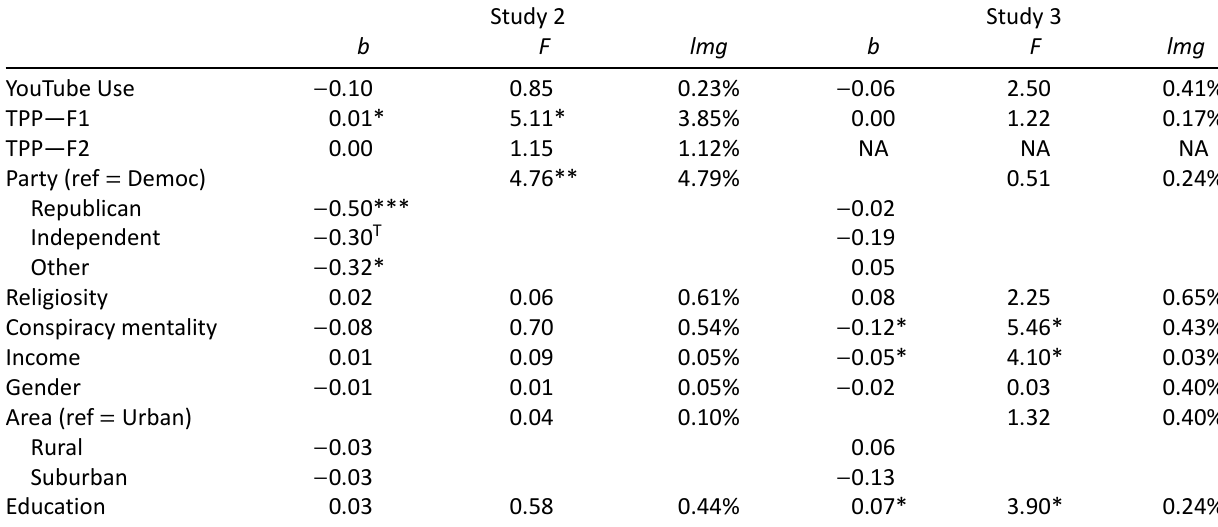
Table 7. Predicting censorship scores. Non-standardized regression coefficients are